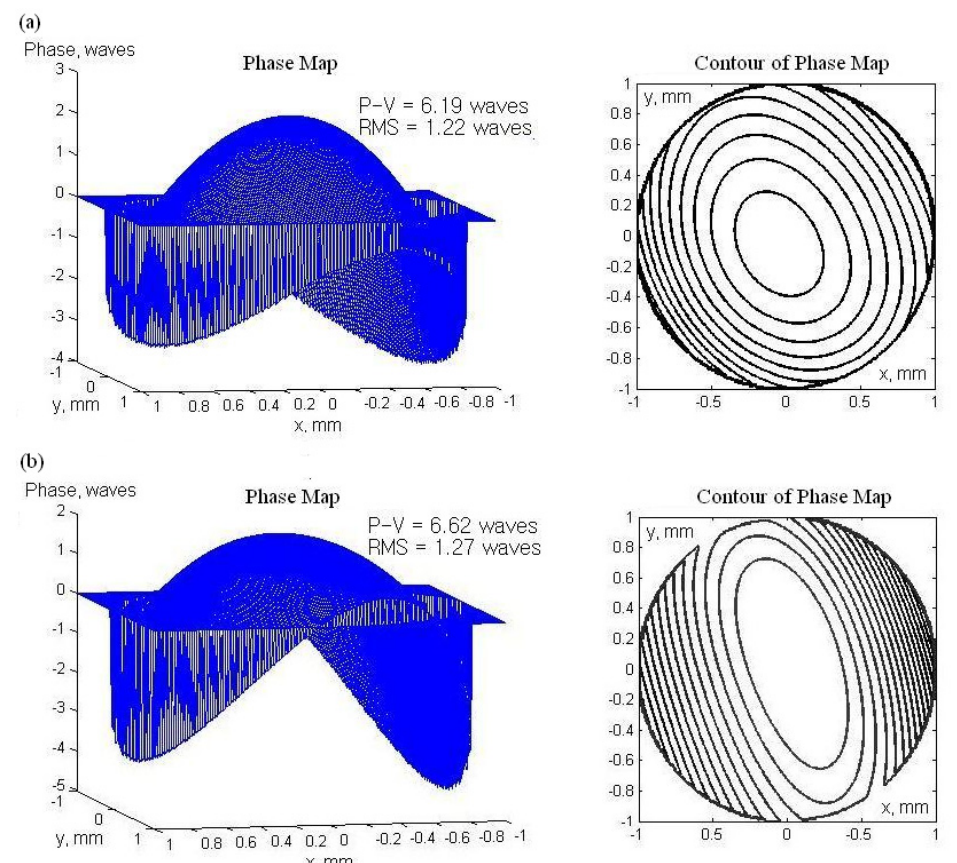
Figure 11. Wavefront measurement results of defocus by using (a) long focal length (UV-resin) and (b) shorter focal length (SU-8) MLA as our SHWS lenslet